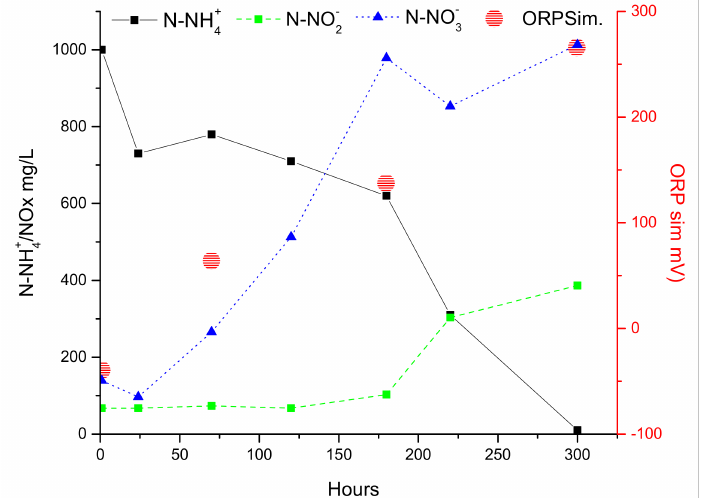
Figure 7. Simulation derivate by ORP and empirical data (red circle) and the evolution of nitro- gen